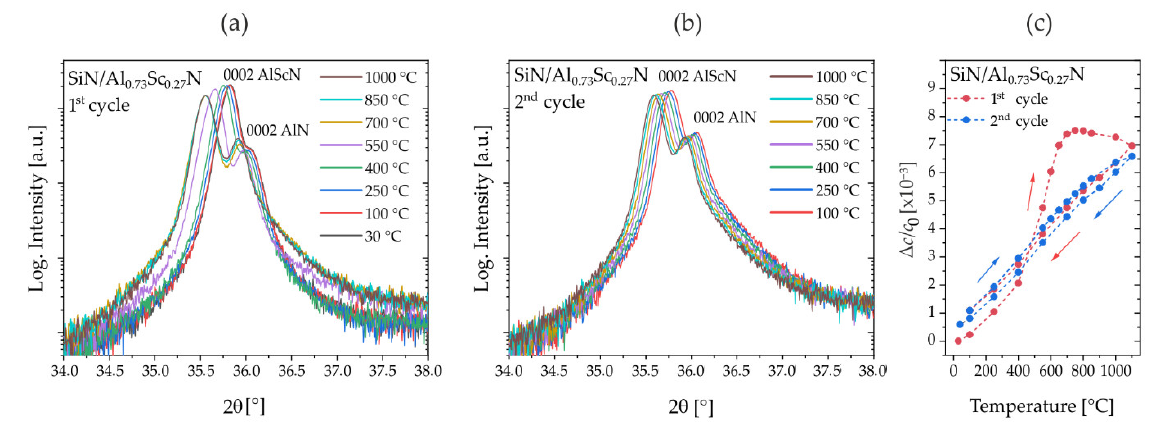
Figure 2. XRD in situ (with oxygen atmosphere) annealing experiments. Observation of anomalous XRD in situ (with oxygen atmosphere) annealing experiments. Observation intrinsic lattice expansion on oxygen-protected SiN passivated thin films of of anomalous intrinsic lattice expansion on oxygen-protected SiN passivated thin films of Al 0.73 Sc 0.27 N(0001)/Mo(110)/AlN(0001)/Si(100) (sample set #1). ( a ) 2θ/θ-scan: Evolution of the 0002- Al 0.73 Sc 0.27 N(0001)/Mo(110)/AlN(0001)/Si(100) (sample set #1). ( a ) 2 θ / θ -scan: Evolution of the reflection profile during the first cycle. ( b ) 2θ/θ-scan: Evolution of the 0002-reflection profile during 0002-reflection profile during the first cycle. ( b ) 2 θ / θ -scan: Evolution of the 0002-reflection profile the second cycle. ( c ) Relative change Δ c / c 0 in lattice parameter with annealing temperature in two during the second cycle. ( c ) Relative change ∆ c / c 0 in lattice parameter with annealing temperature consecutive annealing cycles. in two consecutive annealing